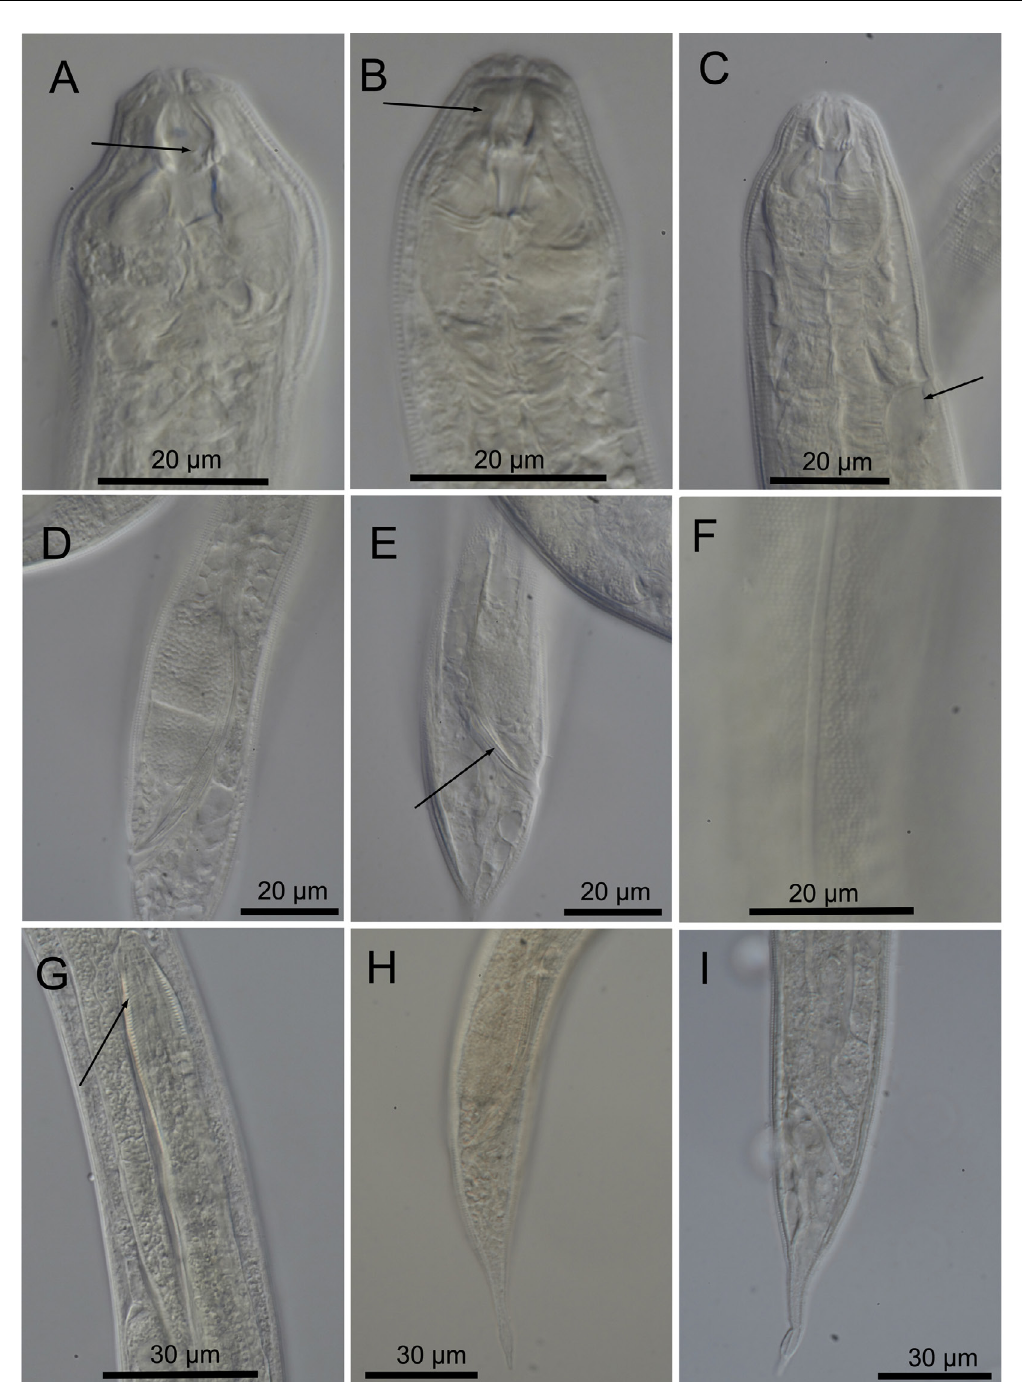
Fig. 3. Cobbionema acrocerca Filipjev, 1922. Light micrographs. A . Female stoma showing stoma armament, arrow pointing to the left ventrosublateral tine (SMNH-179217). B . Anterior part of a female with arrow pointing to the sphincter muscle surrounding the anterior stoma chamber (SMNH-179217). C . Anterior part of a female with arrow showing the ampulla of the secretory-excretory system (SMNH- 179218). D . Caudal region a male showing spicule. E . Caudal region of a male showing the crura (arrow) (SMNH-179218). F . Cuticle showing lateral ala (SMNH-179223). G . Nematode prey inside a female (arrow) (SMNH-179216). H . Male caudal region (SMNH-179217). I . Female caudal region